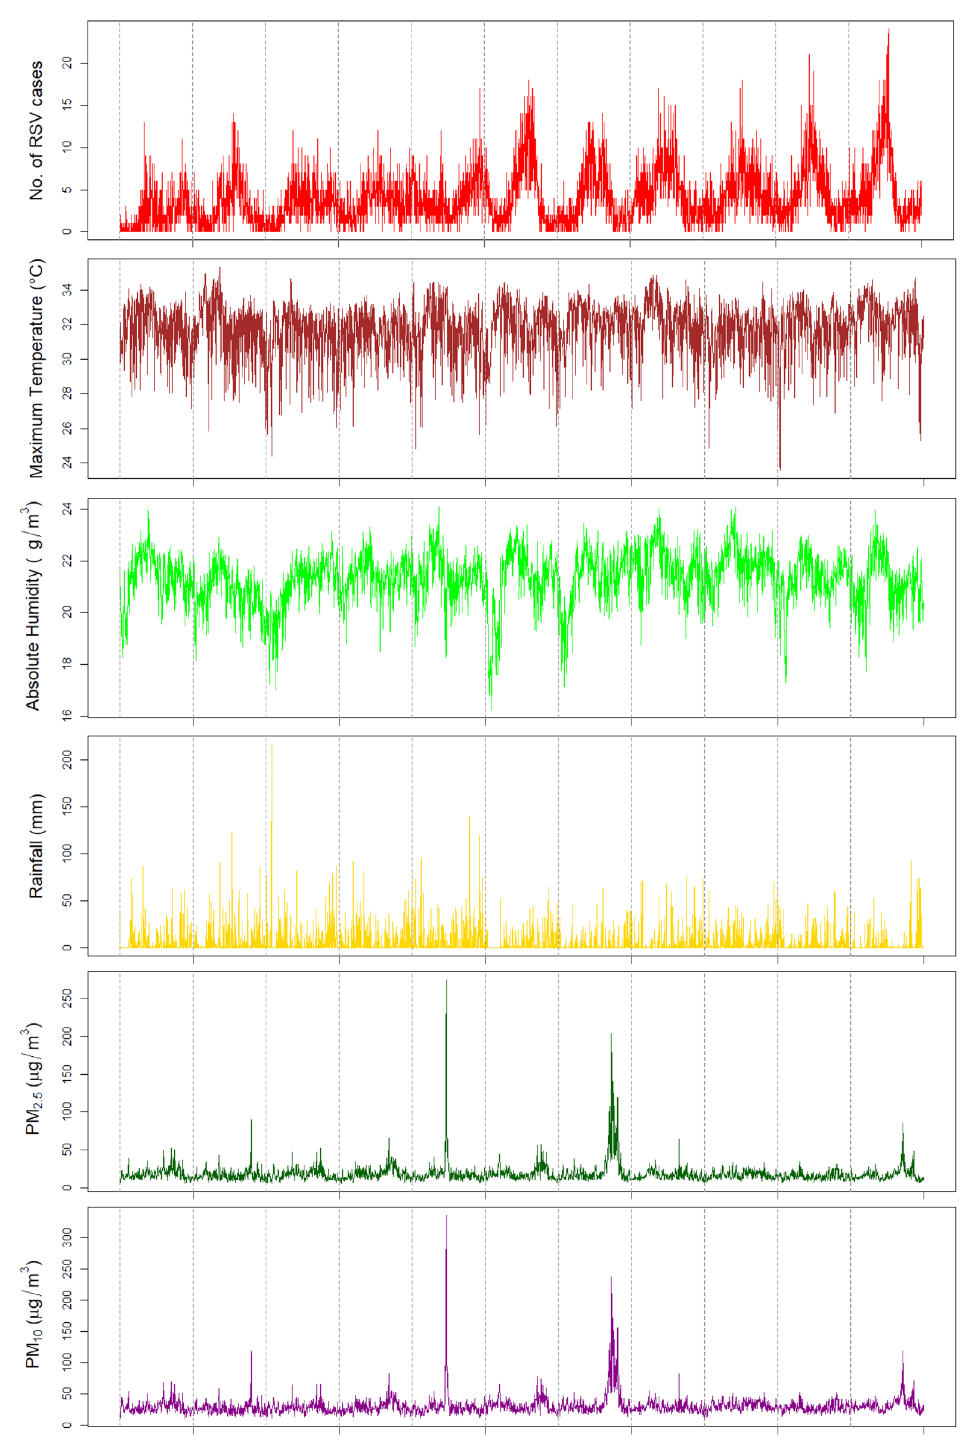
Figure 1. Dily measures of RSV incidence, meteorological factors and air quality from 2009 to